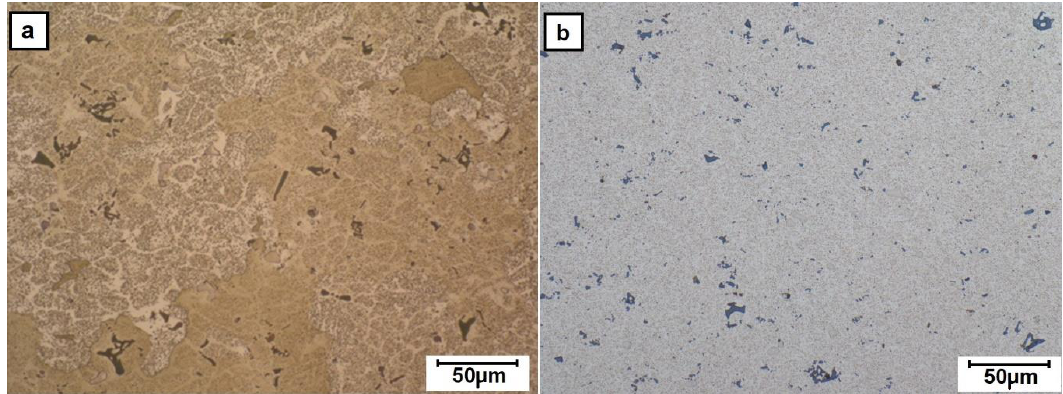
Figure 4. Light microscopy (LM) images of microstructure of sections of 2017A rods prepared for friction-extrusion test of: ( a ) RM and ( b ) extrusion (E) alloy (as purchased).